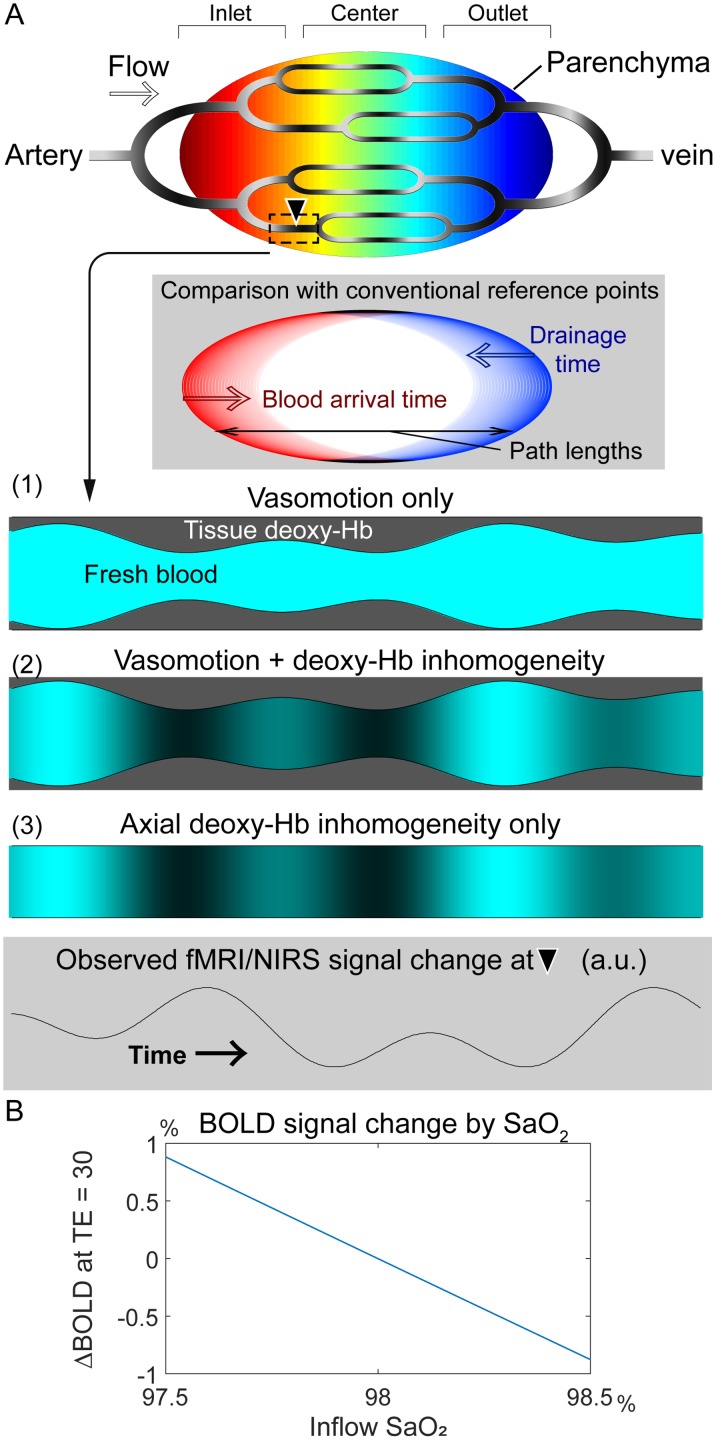
A working model of BOLD lag mapping.(A) A schematic of the cerebral vascular tree presenting possible physiological models that account for the fMRI and NIRS observations. Each brain voxel has its lag (phase) of the spontaneous low frequency oscillation (sLFO) relative to the global signal phase as the reference point, depicted in warm and cool colors. The inlet, center, and outlet parts of the gross vasculature are determined purely by the temporal relationship and not by vessel types; all signals should originate from the capillary bed. Another schematic (shaded background) is inserted to illustrate the relationship between reference point selection and vascular path length, which accounts for the disagreement with other blood-tracking techniques. Below are 3 models with different physiological signal sources that are moving along the vasculature. The current model with constant deoxy-Hb requires vasomotion to account for the sLFO (1). While the axial inhomogeneity of the deoxy-Hb density may be linked with vasomotion (2), it can persist without it (3). The moving axial inhomogeneity creates a similar temporal profile with varying phases across regions. (B) Dependence of the BOLD signal on inflow oxygen saturation (SaO2) at 3 T, TE = 30 ms. All other parameters were held constant at physiological values: oxygen extraction fraction = 45%, tissue blood volume fraction = 3%, and hematocrit = 40% (see Eqs (1) and (2)). BOLD, blood oxygen level-dependent; fMRI, functional magnetic resonance imaging; NIRS, near-infrared spectroscopy; TE, echo time; Hb, hemoglobin.